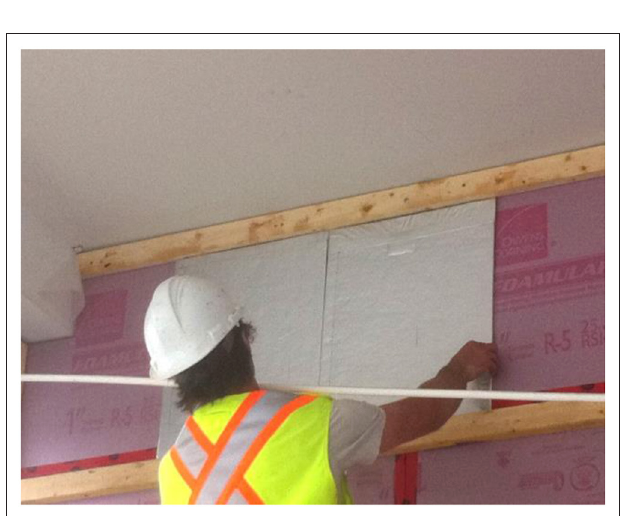
FIGURE 3 | Installation of VIPs over a layer of XPS and a 0.15mm (6 mil) polyethylene air vapor barrier on the existing concrete block wall ( MacLean and Korn, 2011 ).